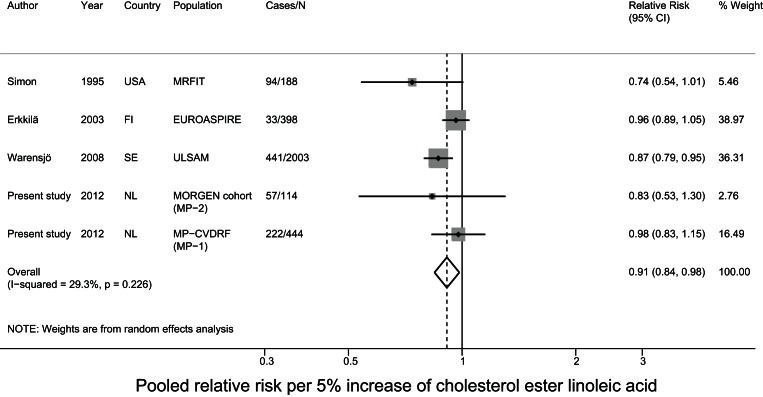
Pooled relative risk of cholesterol ester linoleic acid and CHD risk.